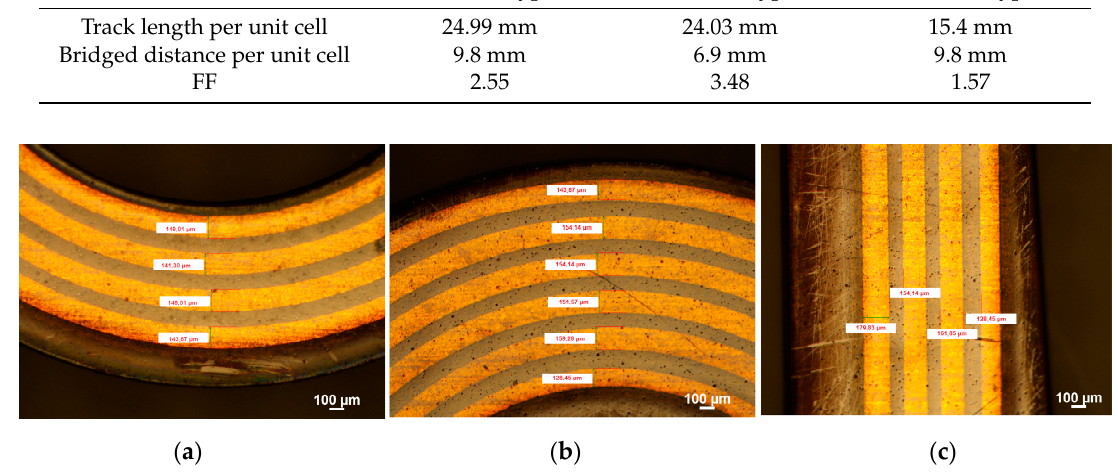
Figure 9. Comparison of copper track width on meander design 1 ( a ), meander design 1-1 ( b ) and meander design 1 middle part ( c ).